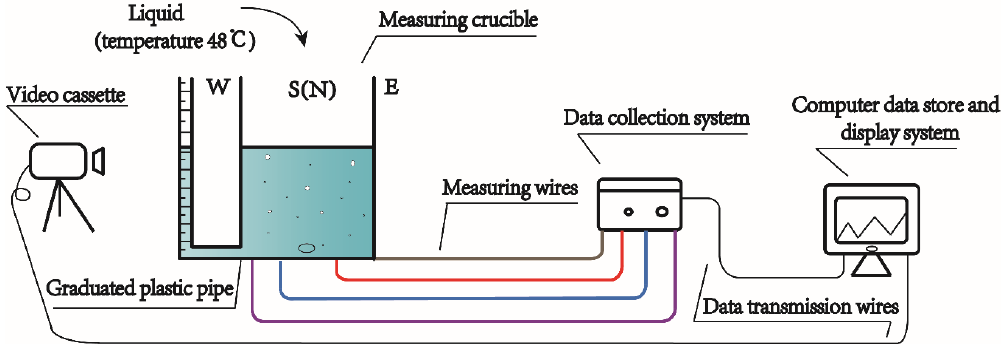
Figure 4. EMF signal and image acquisition system during tapping (N,S,W and E mean north, south, west and east respectively in this